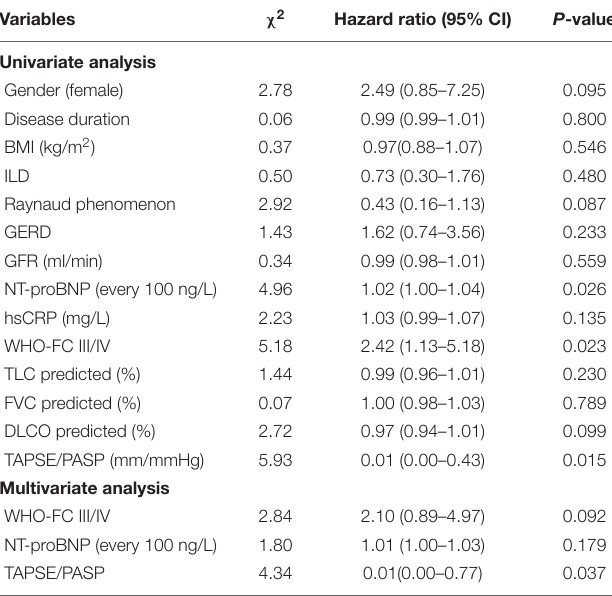
TABLE 3 | Prognostic analysis for the association between TAPSE/PASP and composite endpoint.